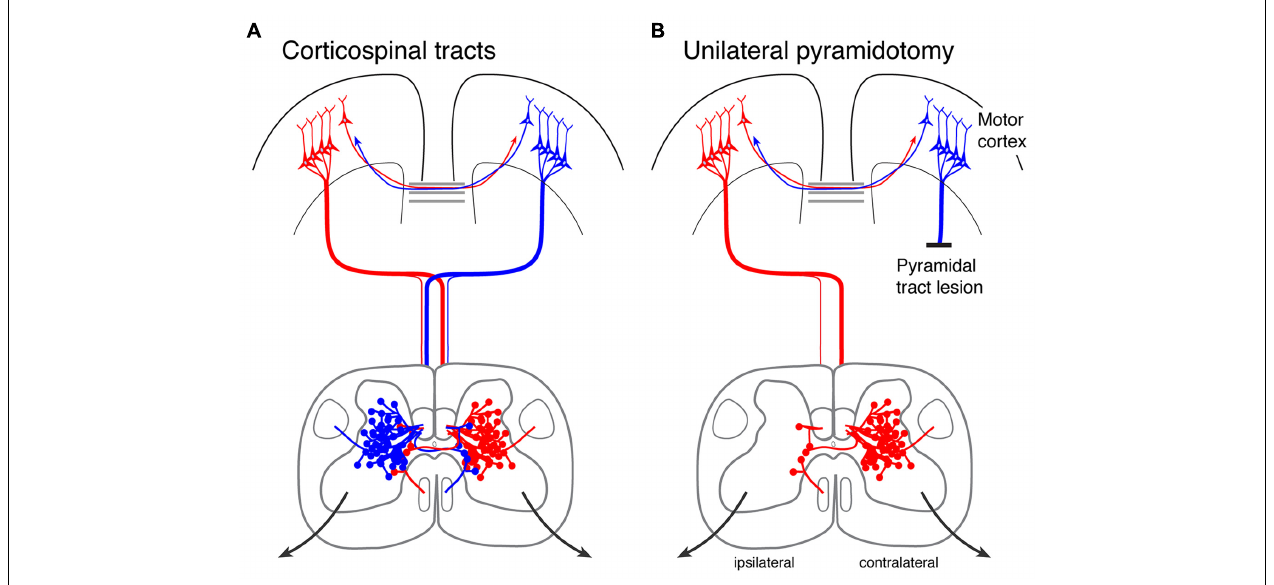
hemisphere gives rise to dense contralateral and sparse ipsilateral spinal terminations. (B) Unilateral pyramidal tract lesion (pyramidotomy) eliminates all corticospinal tract axons from one hemisphere. What remains on the affected side are sparse terminations from the ipsilateral motor